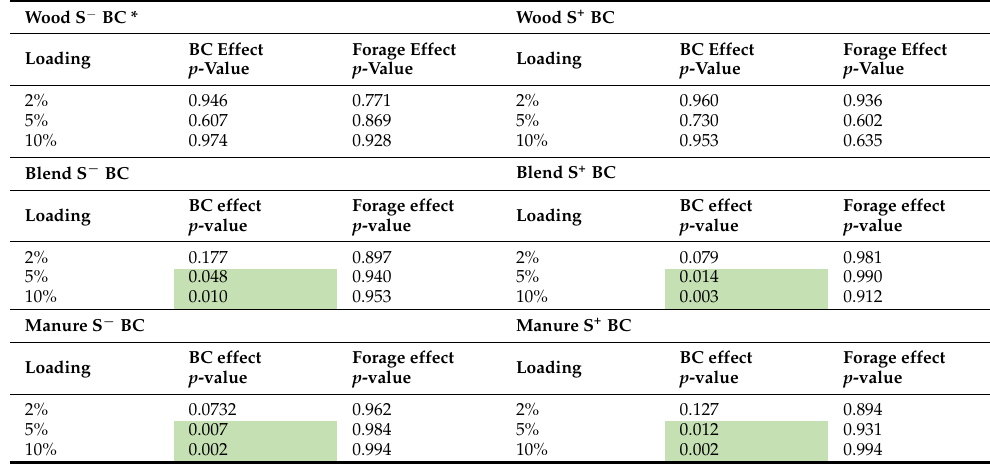
Table 9. Impact of biochar and forage application on soil phosphorus for Trifolium incarnatum . Green highlighted cells are significant ( p ≤ 0.05)